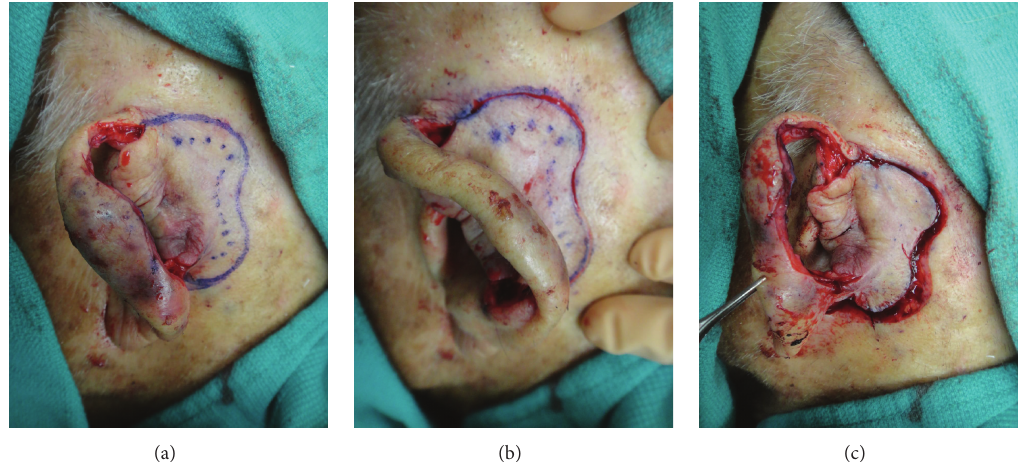
Figure 5: The defect served as a stencil on the postauricular skin to create the island, which was incised and undermined at the edges to allow for elevation.